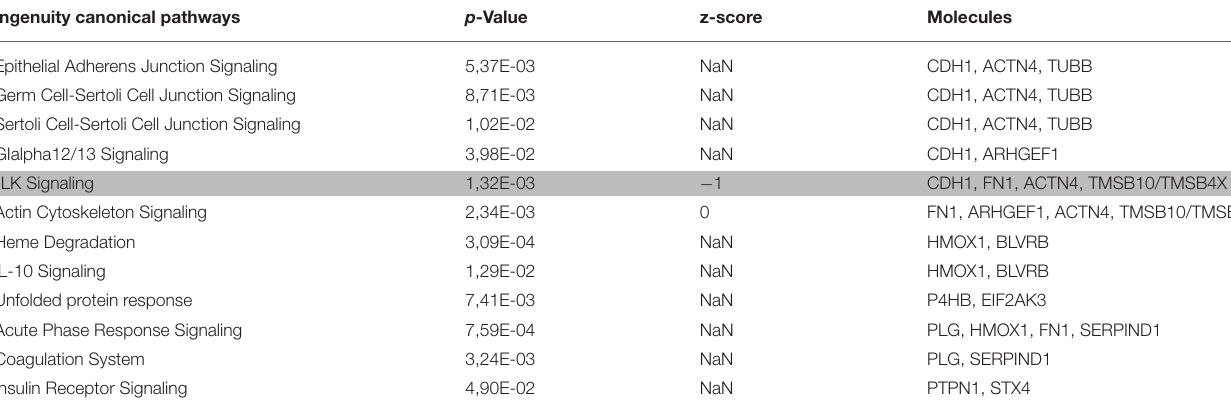
TABLE 6 | IPA bioinformatics comparison of ns-Zr15 vs ns-Zr25. Ingenuity canonical pathways p -Value z-score Molecules Epithelial Adherens Junction